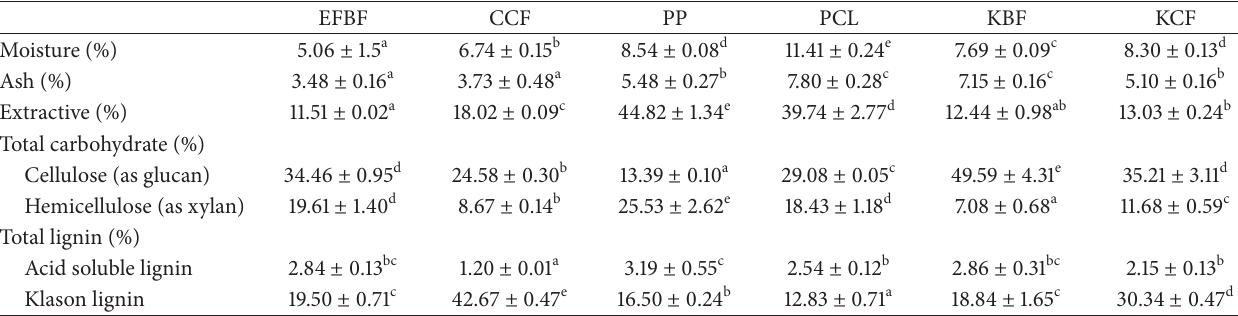
Table 2: Total soluble lignin in black liquor produced from six different biomasses through alkaline and organosolv treatment at 120 ∘ C for an hour ( 𝑛 = 3 ; 𝑃 < 0.05 ). Organosolv treatment Alkaline treatment Biomass Soluble lignin Soluble lignin (mgg − 1 biomass; d.b. ) (mg g − 1 biomass; d.b. )